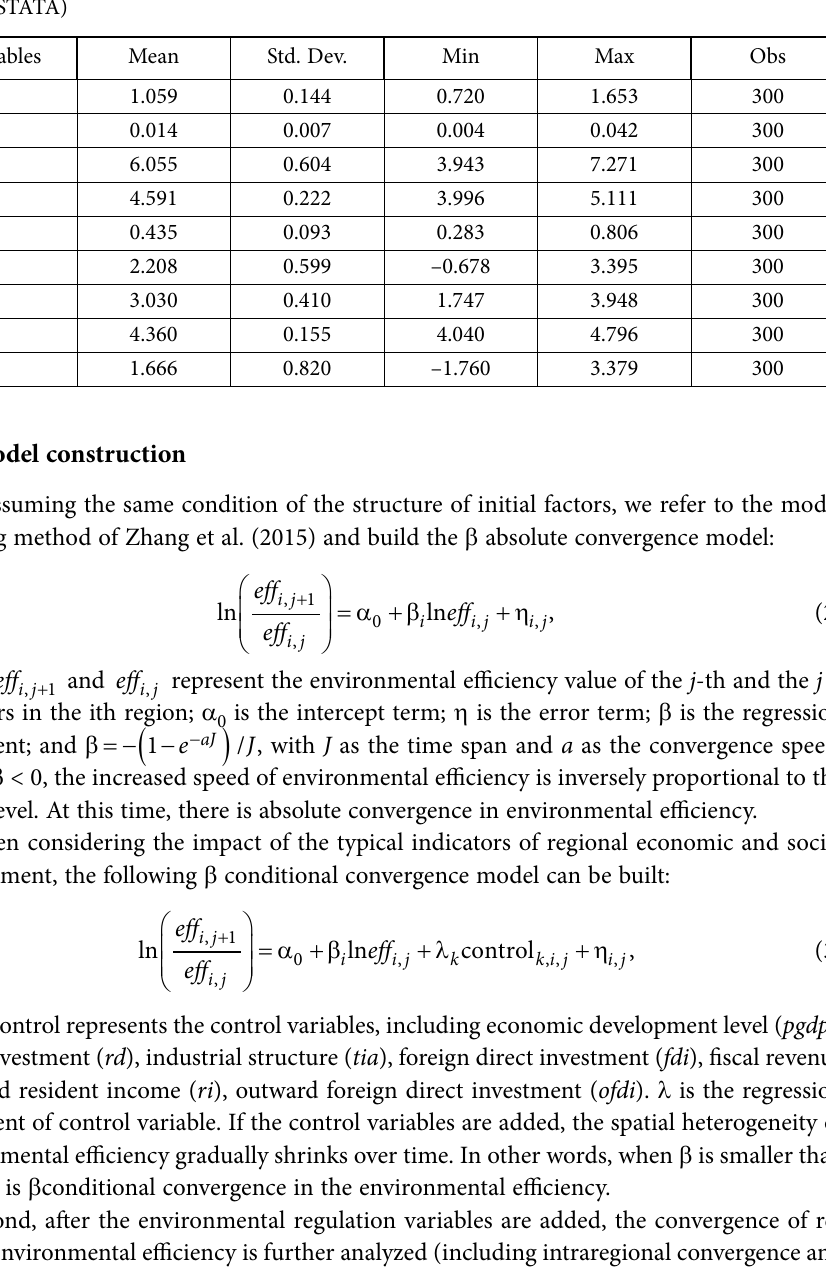
Table 1. Descriptive Statistics of the Variables (source: The data in the table are calculated by the soft- ware of STATA) Variables Mean Std. Dev.